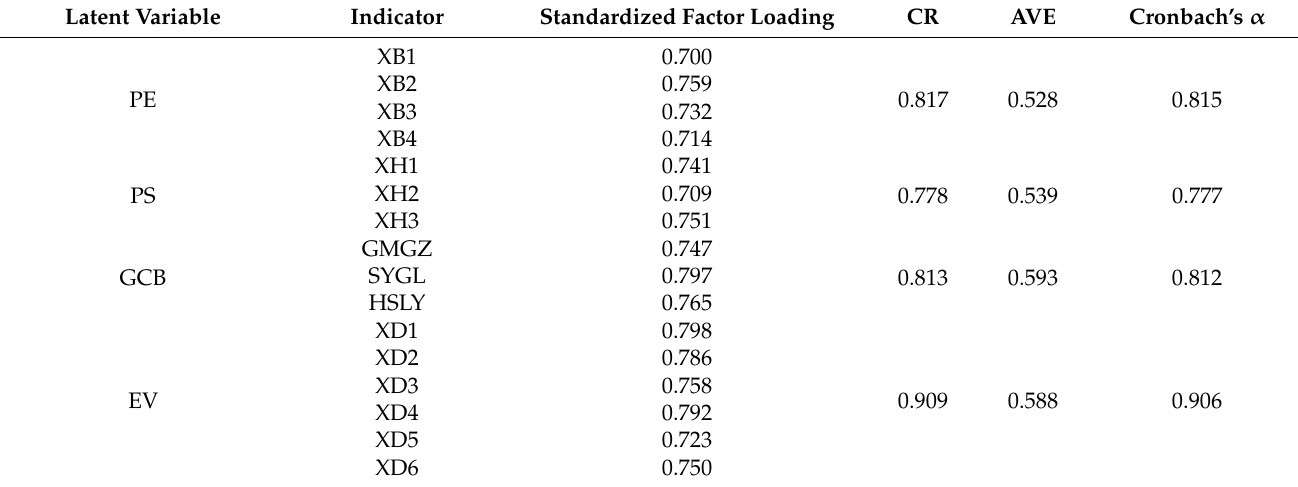
Table 2. Confirmatory factor analysis and reliability analysis results of